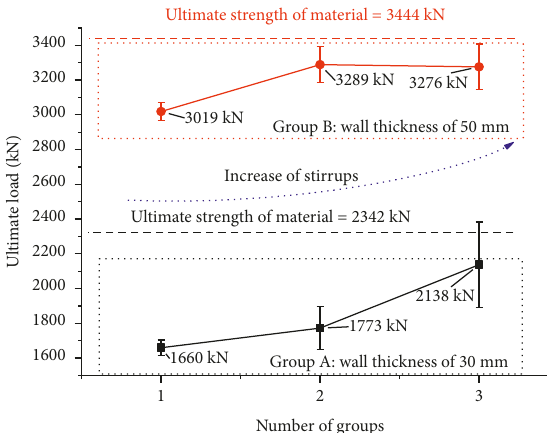
Figure 2: Experimental setup of columns. Figure 3: Ultimate loads of columns.